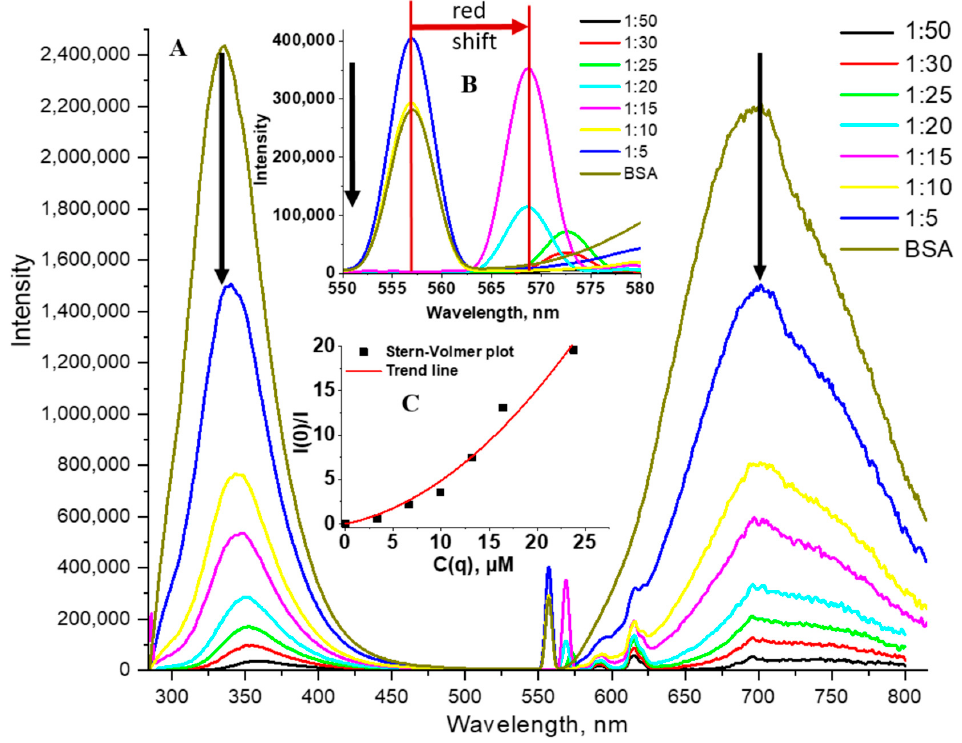
Figure 15. ( A )-Emission spectra of aqueous solutions of BSA with europium (III) complex 10a at different ratios. ( B )-a magnified region of the main graph from 550 to 580 nm. ( C )-Stern–Volmer plot obtained from the results of the photoluminescent titration of an aqueous solution of BSA with a solution of the Eu(III) complex 10a .